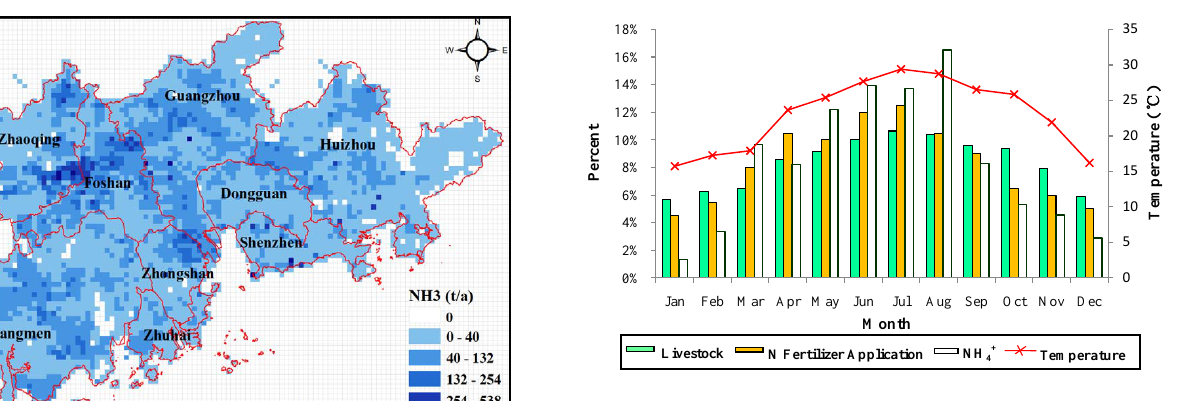
Fig. 8. Monthly variations in emissions from livestock and N fertilizer applications, NH 4+ in precipitation and in temperature.